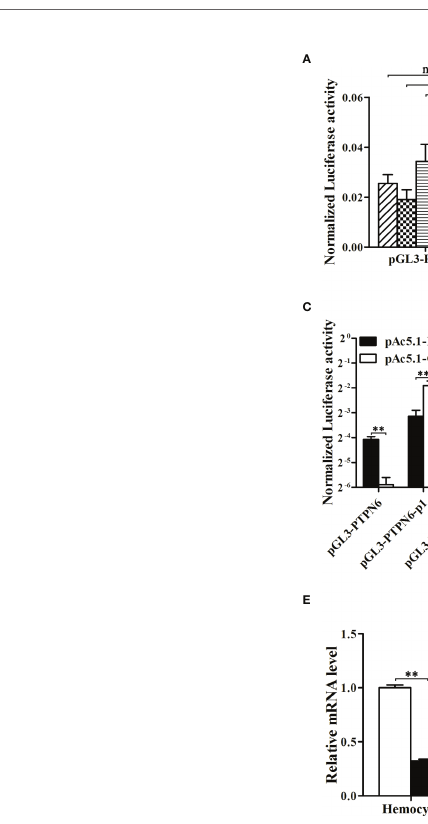
FIGURE 5 | Regulation of LvPTPN6 expression by IRF. (A) Regulatory effects of Dorsal, Relish, STAT, IRF, and GFP (as control) on the LvPTPN6 promoter. Each bar represents the mean ± SD ( n = 8), ** p < 0.01, * p < 0.05, and ns : P > 0.05 by two-tailed unpaired Student ’ s t -test. (B) Scheme of the cleaved promoters of LvPTPN6. (C) Regulatory effects of IRF and GFP on the cleaved promoters of LvPTPN6. Each bar represents the mean ± SD ( n = 8), ** p < 0.01 by two-tailed unpaired Student ’ s t -test. (D) Interaction of IRF with the LvPTPN6 promoter analyzed by EMSA. The biotin-labeled (Bio-) or unlabeled (Unbio-) probes and puri fi ed prokaryotic protein of LvPTPN6 or TRX (as control) are used. (E, F) qRT-PCR analysis of IRF and LvPTPN6 mRNA levels in hemocyte and gill at 48 h post dsRNA injection. Values in the dsRNA-GFP control group were set as the baseline (1.0). Each bar represents the mean ± SD ( n = 4), ** p < 0.01 by two-tailed unpaired Student ’ s t -test.